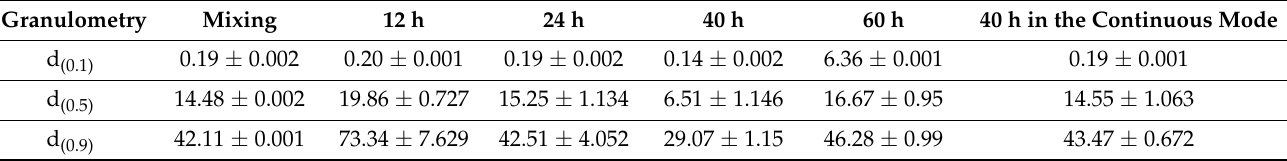
Figure 3. The cross-sectional BSE images of powders embedded in resin after ball milling for different Table 3. Particle size ( µ m) distribution obtained by laser